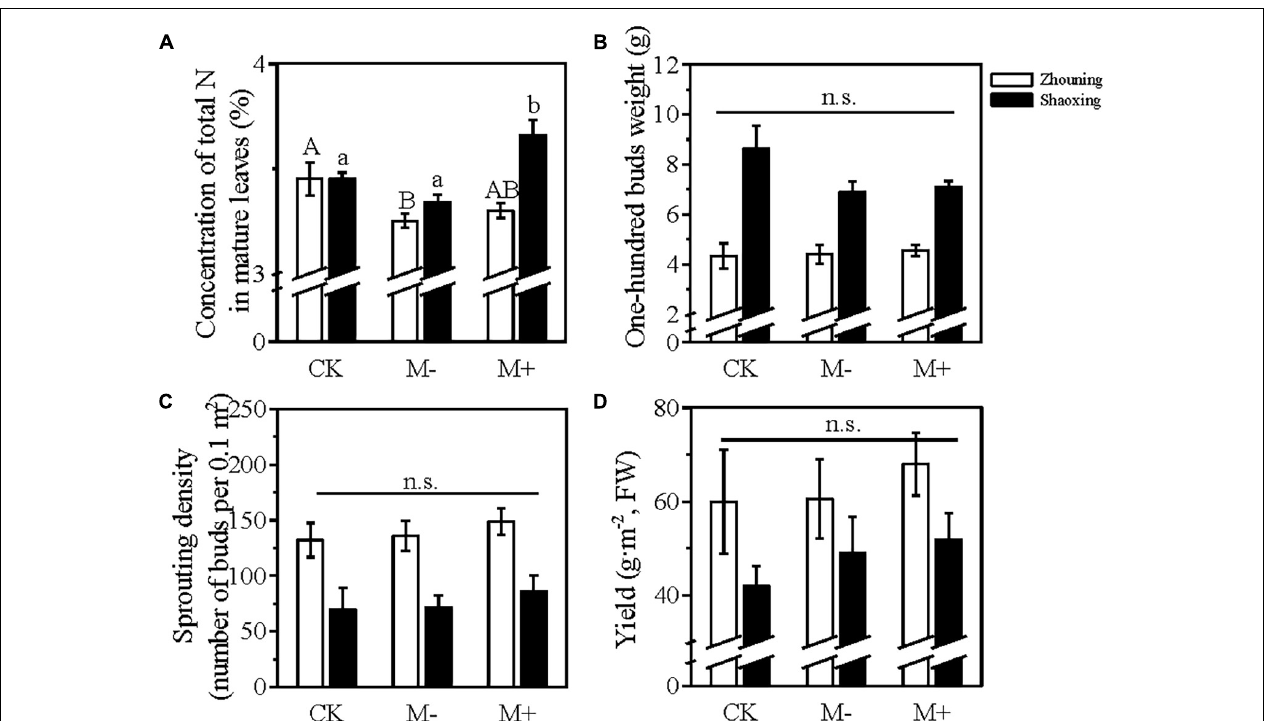
FIGURE 6 | Field experiment investigating the effect of foliar N application on tea plants grown under a reduced soil fertilization level. (A) The concentration of total N in the mature leaves before the sprouting of dormant buds; (B) 100 buds weight; (C) sprouting density; (D) yield of spring tea. FW, fresh weight. CK, tea plants cultivated using the local soil fertilization level in Zhouning or Shaoxing without foliar N application; M − & M+, tea plants cultivated in the presence of 25% reduced soil fertilization level without (M − ) or with (M+) foliar N application. Values were shown as means ± SEs [ n = 6 for all the samples from Shaoxing, n = 4 for samples in panel (A) from Zhouning, n = 9 for samples in panels (B–D) from Zhouning]. The significance of different treatments from the same district was evaluated using one-way ANOVA followed by a Duncan test at a significance level of P 0 . 05 in SPSS 22.0 software. Statistically significant differences ( P < 0.05) among the treatments in Zhouning and Shaoxing were shown with a capital letter and a lower case letter displayed above the bar plot, respectively; n.s. indicated no